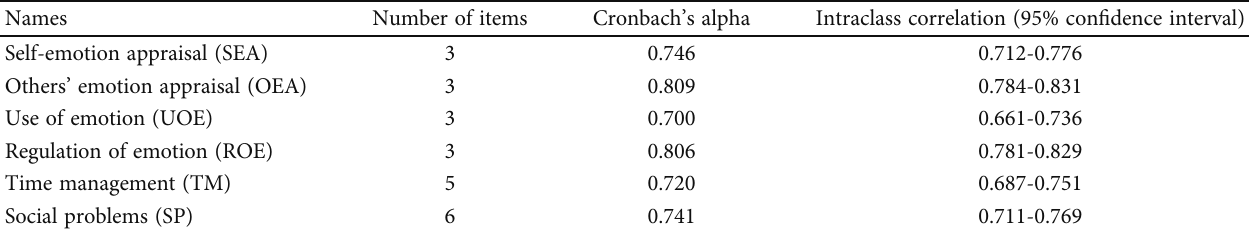
Table 3: Summary of variables.